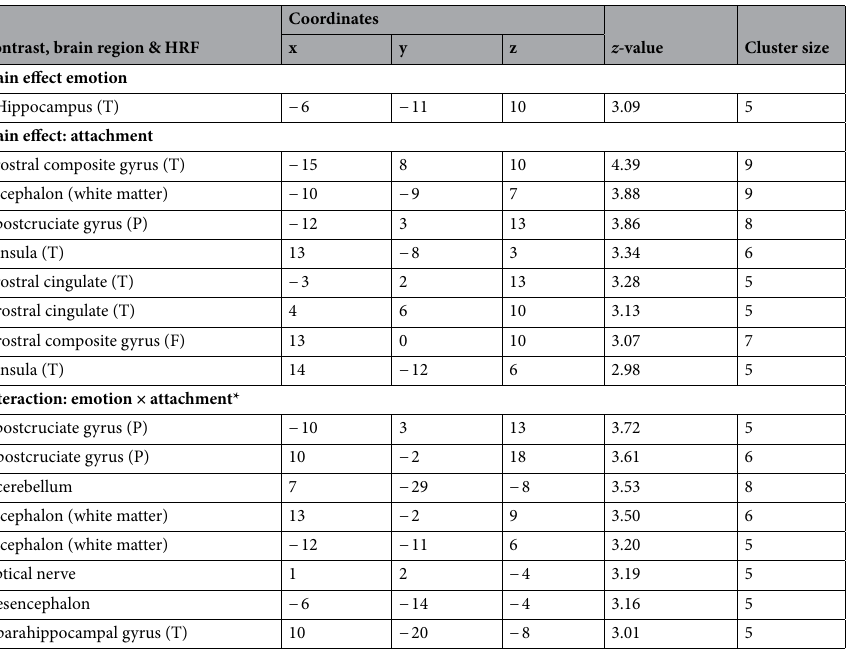
Table 1. Experiment 1 (fMRI), N = 17: Task-related activation during visual stimulation. Main and interaction effects were tested for significance with a cluster-defining threshold of p < 0.005 uncorrected and a minimum cluster size of 5 voxels. The first local maximum within each cluster is reported; coordinates represent the location of peak voxels and refer to the canine breed-averaged template 65 . The template along with another single dog template 66 served to determine anatomical nomenclature for all tables. See Table 2 for contrasts most relevant for the present study; Supplementary Table S3 contains further contrasts for full transparency. O occipital lobe, T temporal lobe, P parietal lobe, O occipital lobe, L left, R